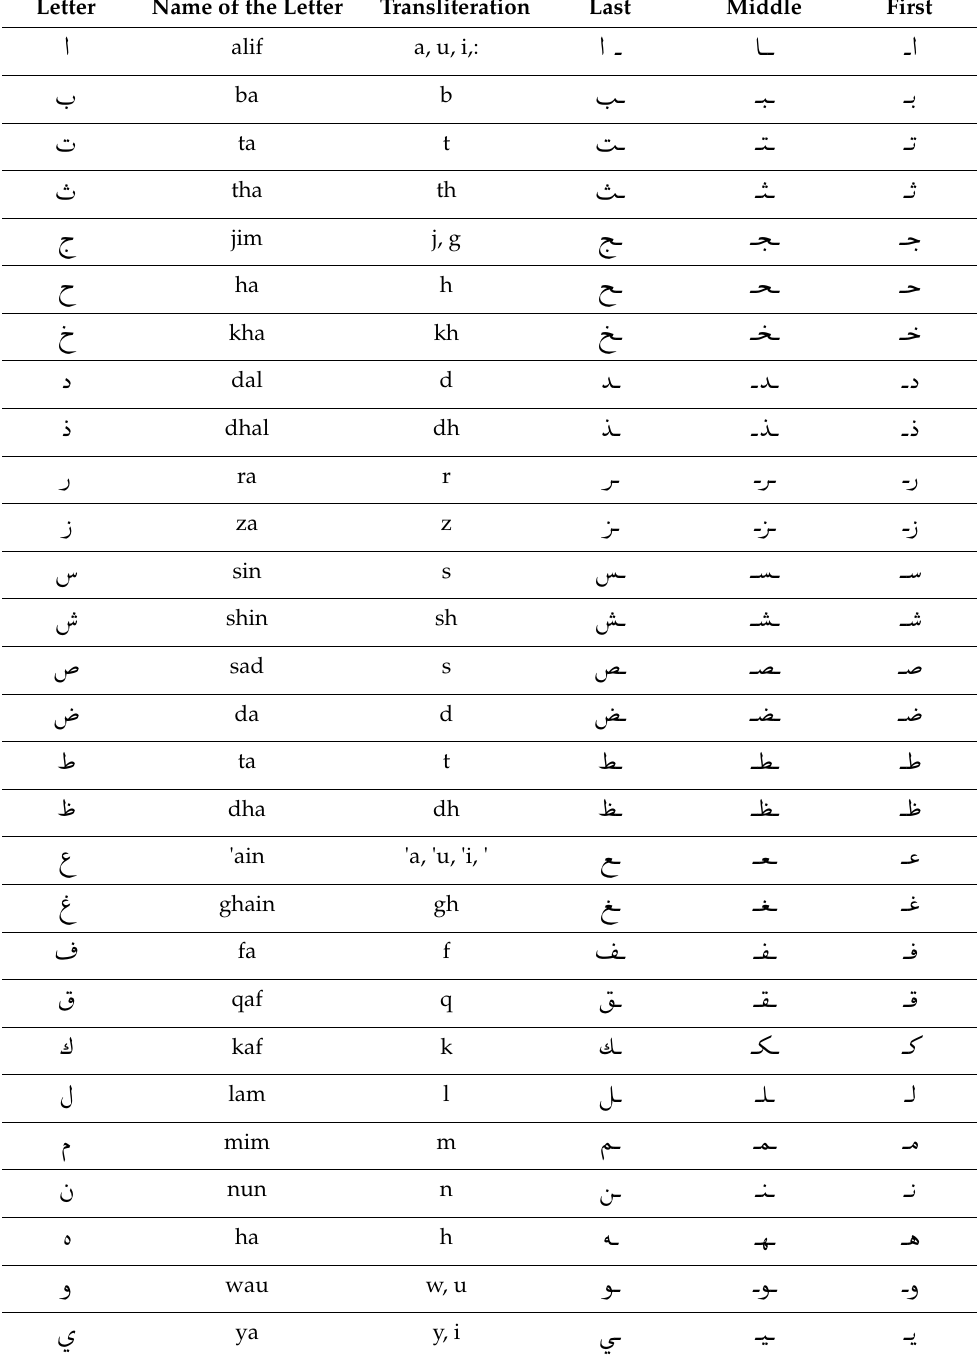
Table 7. Translation of Arabic